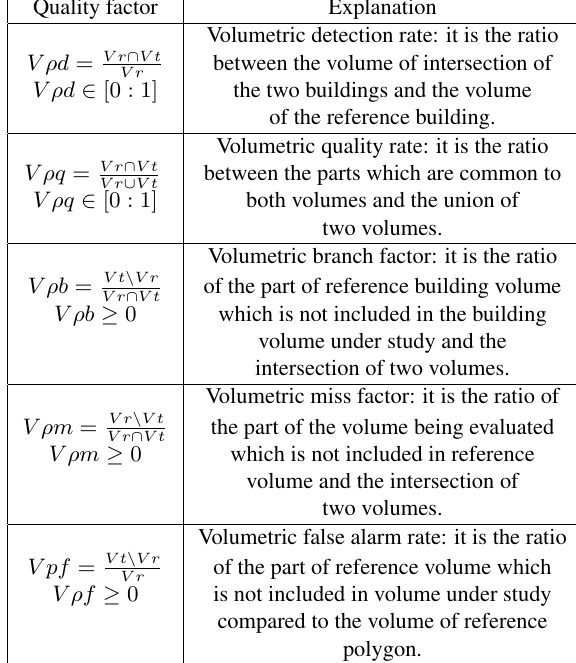
Table 2: Quality indices based on volume